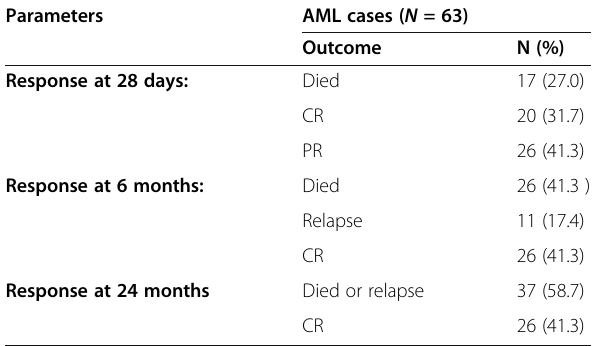
Table 3 Response to therapy and patient ’ s outcome in all AML